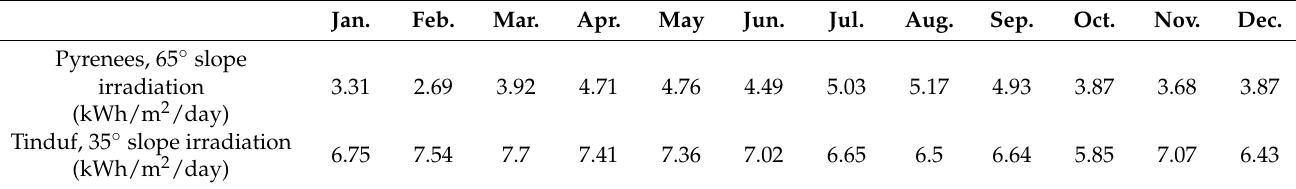
Table 2. Table 2. Monthly average irradiation data from Photovoltaic Geographical Information System (PVGIS) [52], year 2015. Jan.